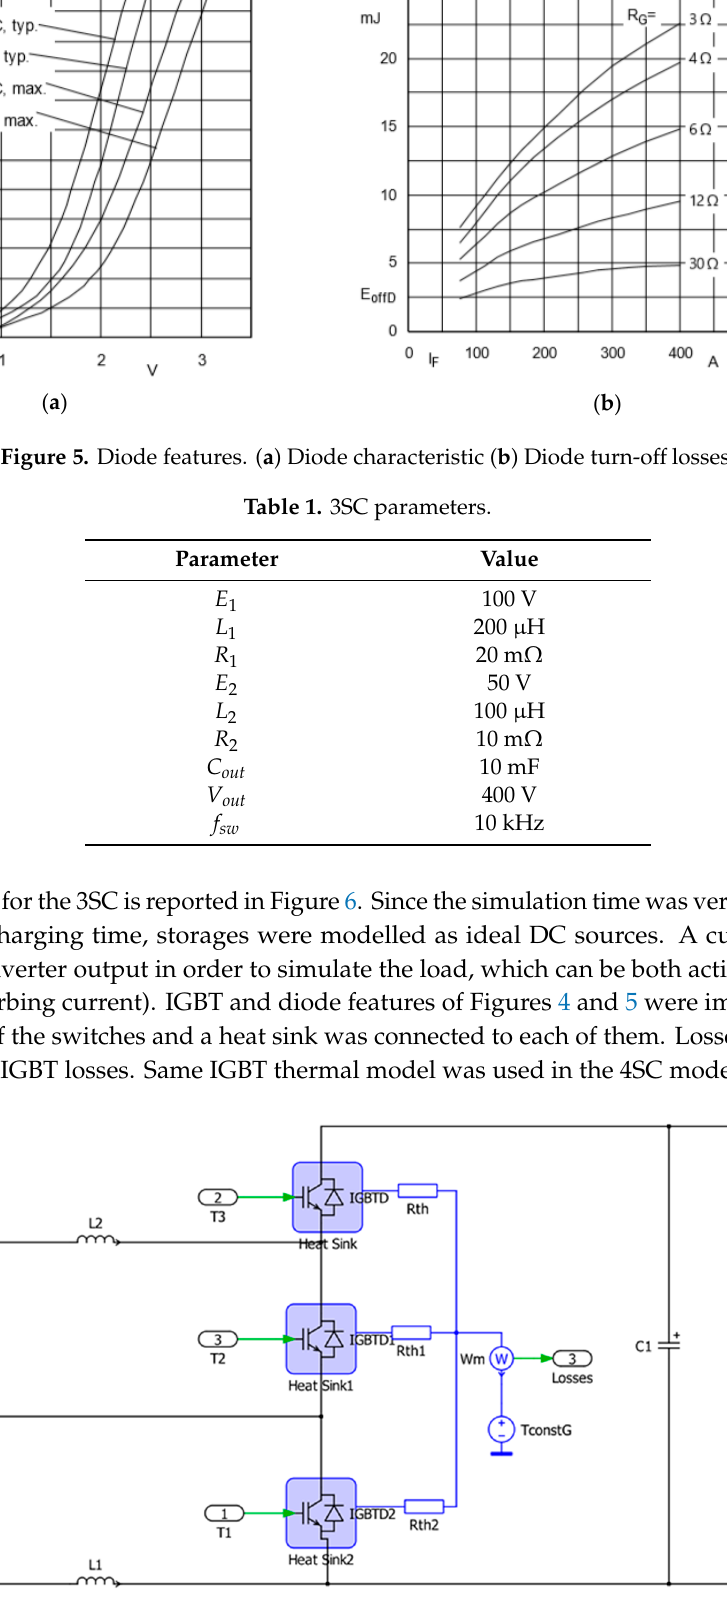
Figure 6. 3SC Plecs model . Figure 6. 3SC Plecs